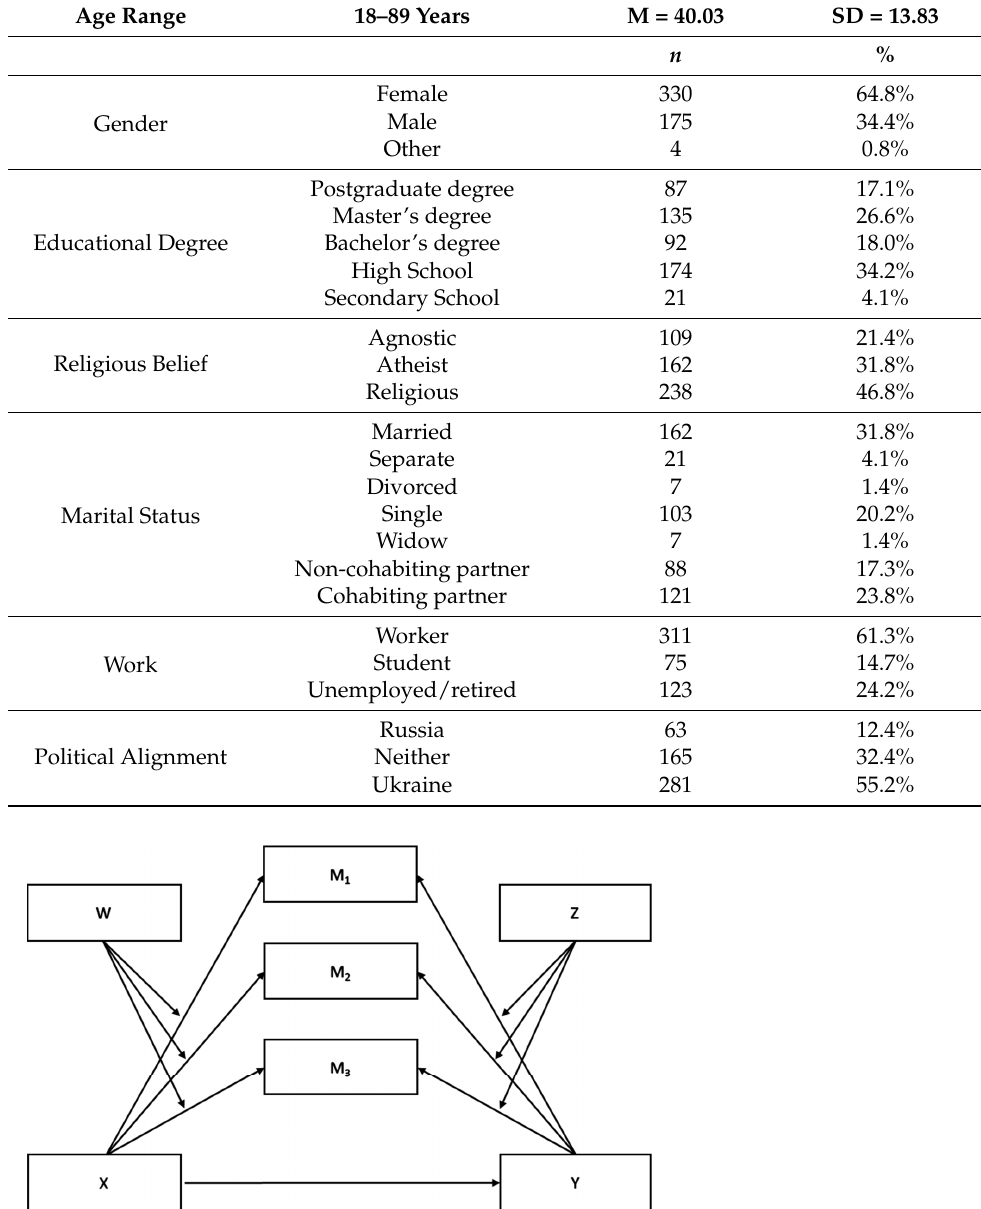
Table 1. Demographic characteristics of the sample.